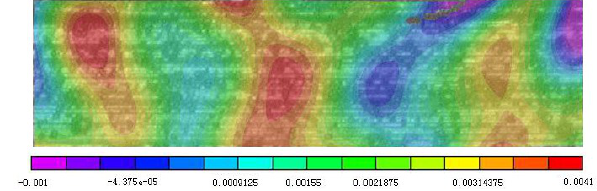
Figure 23: Strain distribution(Force=25N)